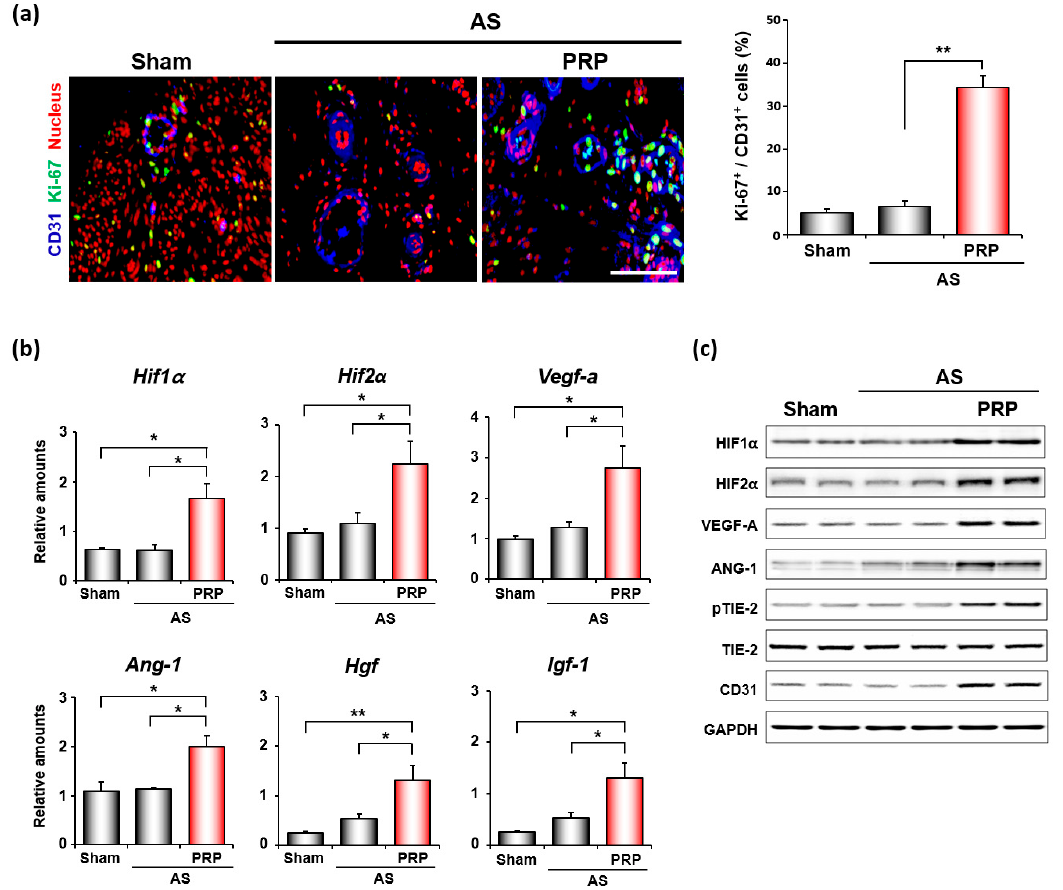
Figure 5. hPRP facilitates angiogenesis in compromised uterus in mice with AS. ( a ) Co-immunofluorescence staining of CD31 and KI-67 in uteri 7 days after intrauterine hPRP administration. Blue, green, and red colors indicate CD31, KI-67, and nuclei, respectively. Yellow nuclei indicate proliferating endothelial cells. The graph depicts the percentage of Ki-67 positive cells/CD31 positive cells counted. Scale bar, 50 μ m. ( b , c ) Quantitative analyses of realtime RT-PCR ( b ) and Western blotting ( c ) of factors important for angiogenesis in uteri with AS after hPRP treatment. * p < 0.05, ** p < 0.01.